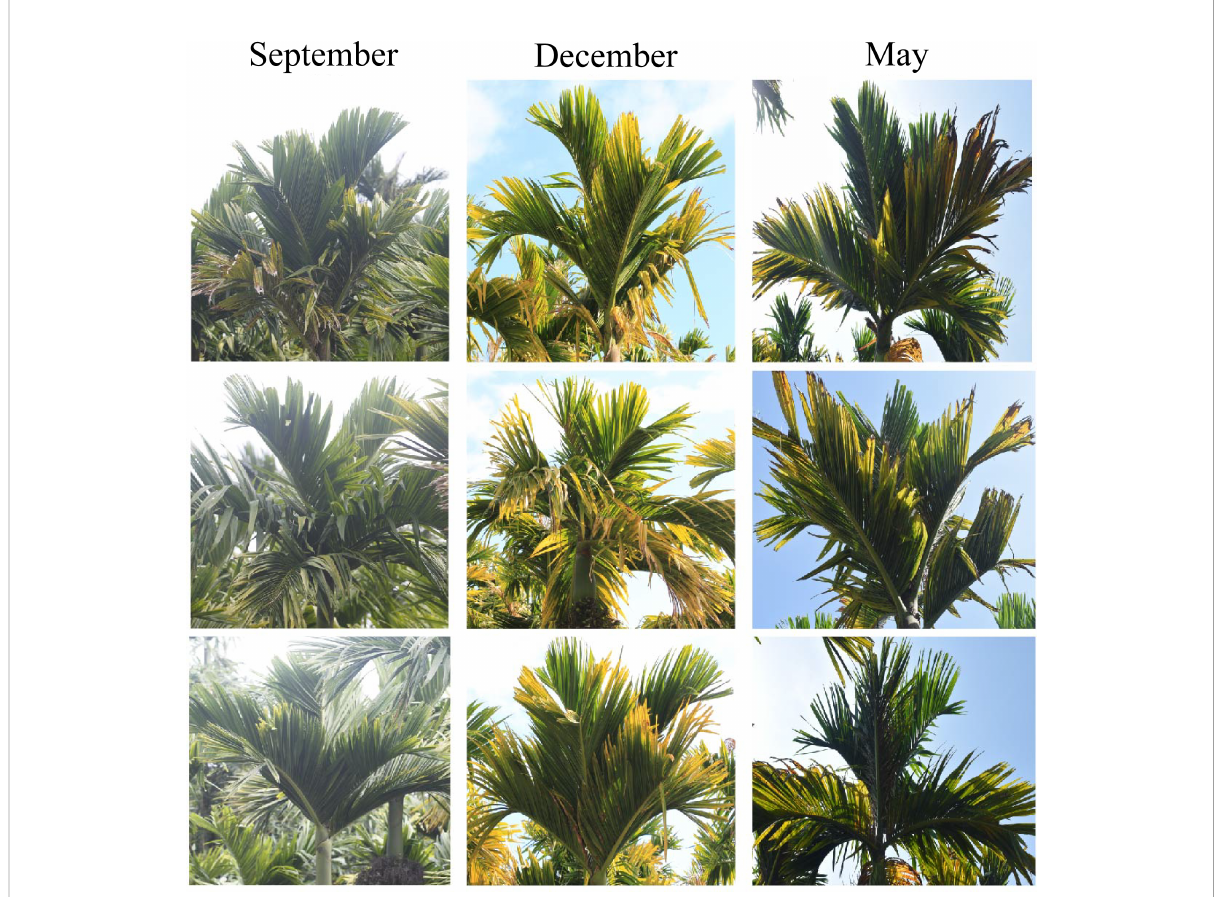
FIGURE 1 Symptoms of YLD recorded in different seasons in the fi eld. (September) The YLD symptoms that were recorded in the autumn season (moderate temperature and rainy weather). (December) The symptoms severity recorded in the winter (low temperature and dry weather).(May) The YLD symptoms recorded in the summer (high temperature and warm weather). The symptom ’ s severity was markedly higher in winter than in autumn and